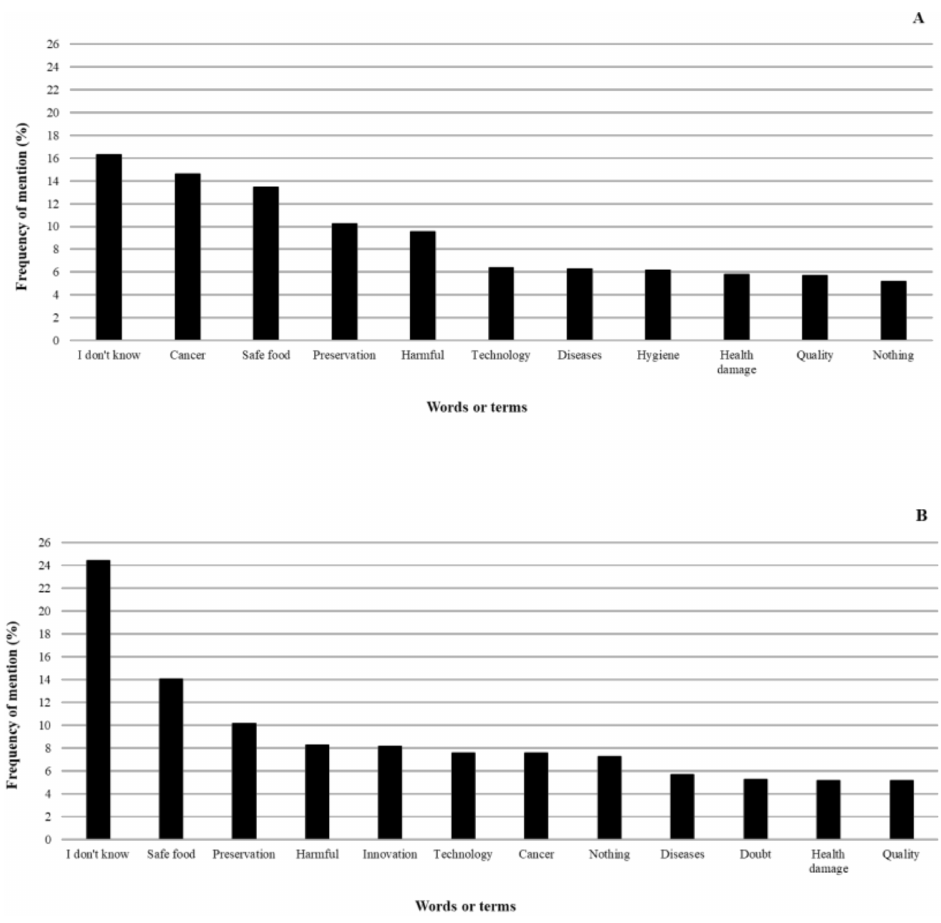
Figure 1. Frequency of mention of the most frequently mentioned words or terms when participants were asked to write down the first four words, terms, or phrases that came to their minds when they thought about food processed by ultraviolet radiation ( A ) and food processed by ultrasound ( B